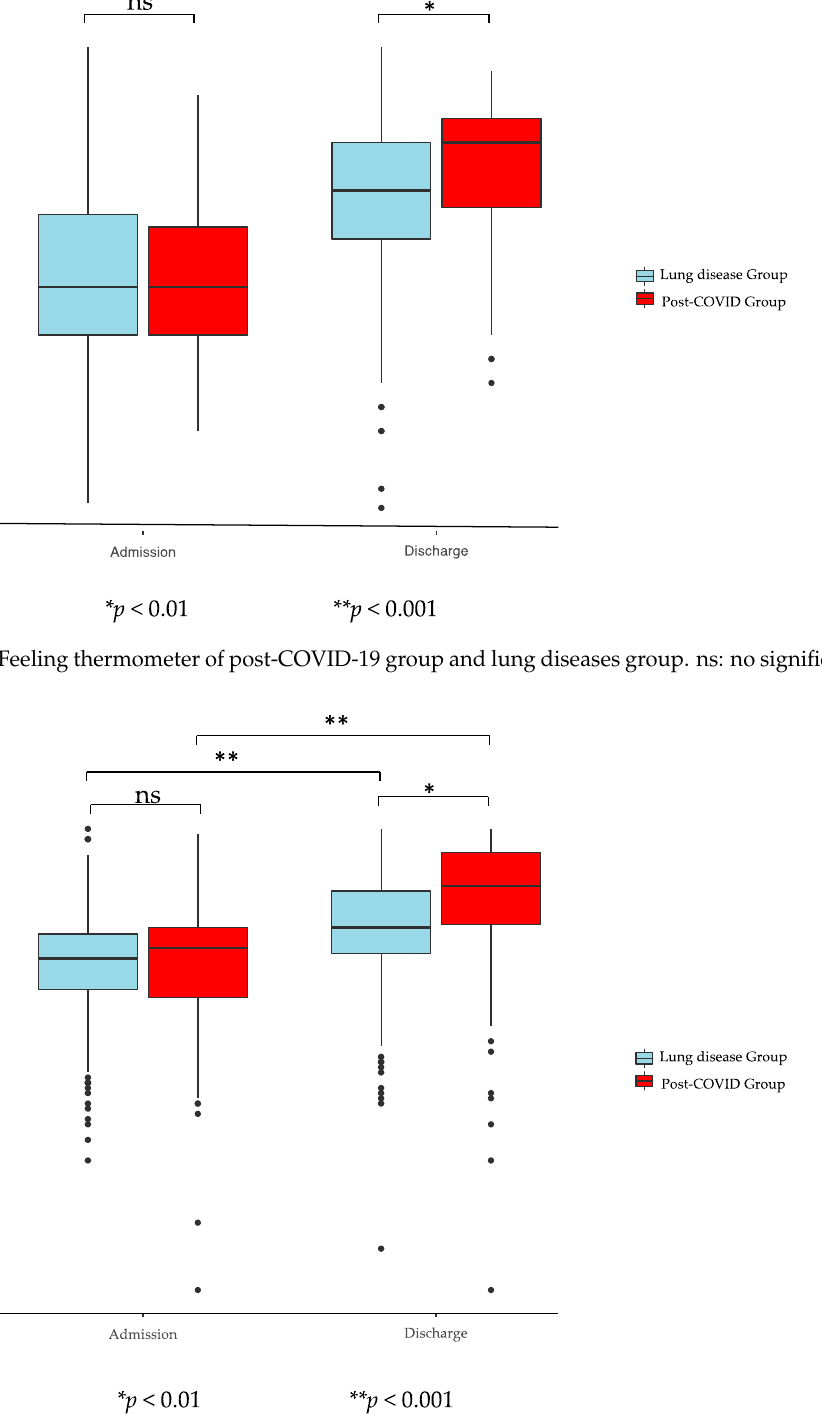
Figure 3. Functional Independence Measurement of post-COVID-19 group and lung diseases group. ns: no significative.